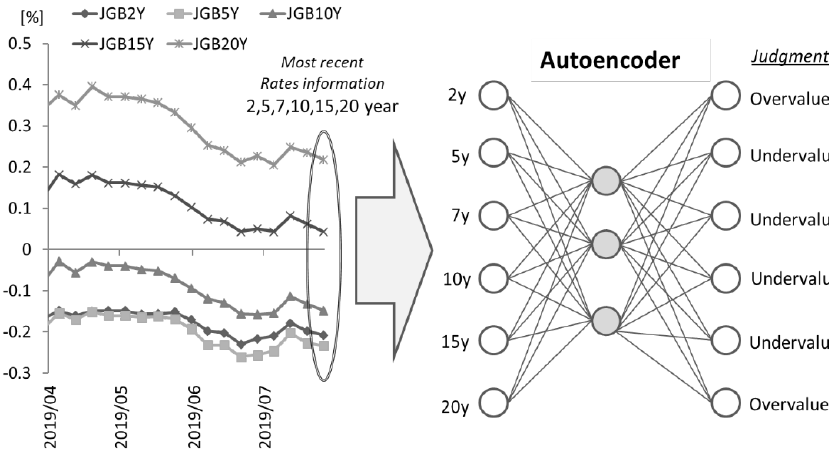
Figure 12. Judgments of overvaluation or undervaluation using an autoencoder.